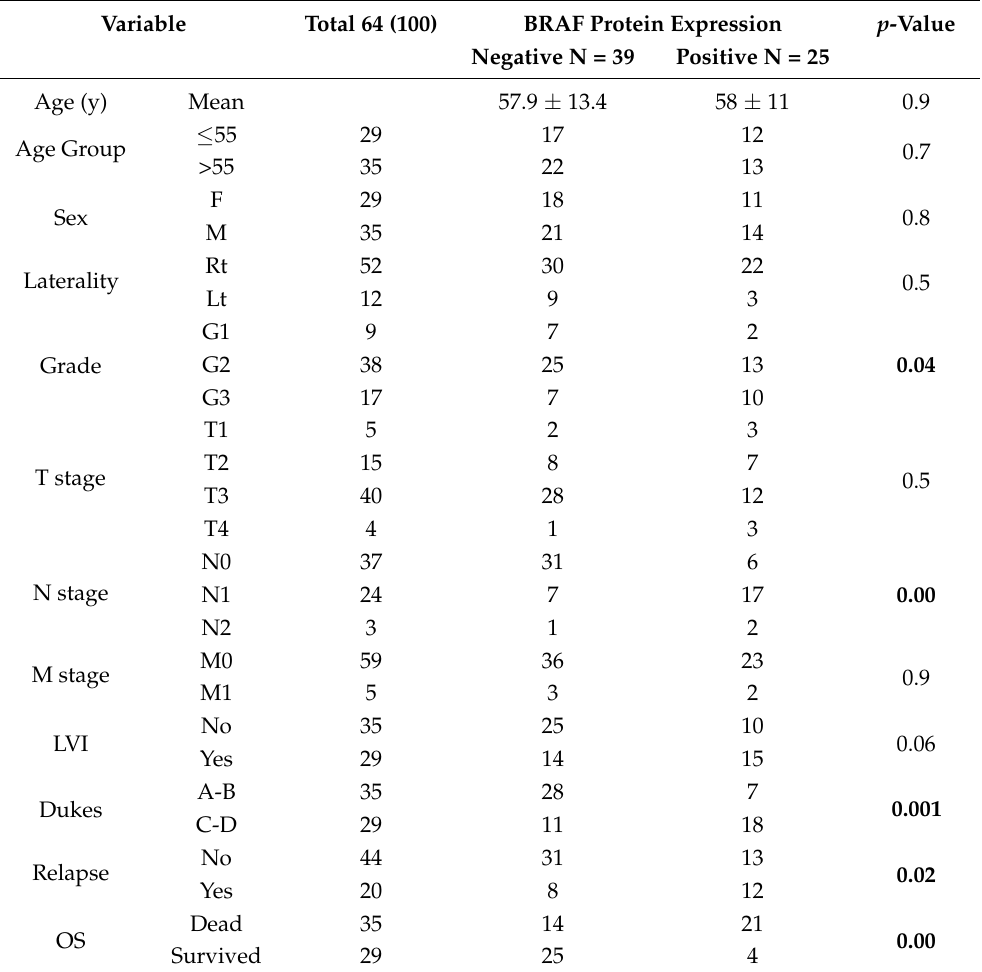
Table 2. Association of BRAF protein expression status and clinicopathological prognostic factors of colorectal cancer. Variable Total 64